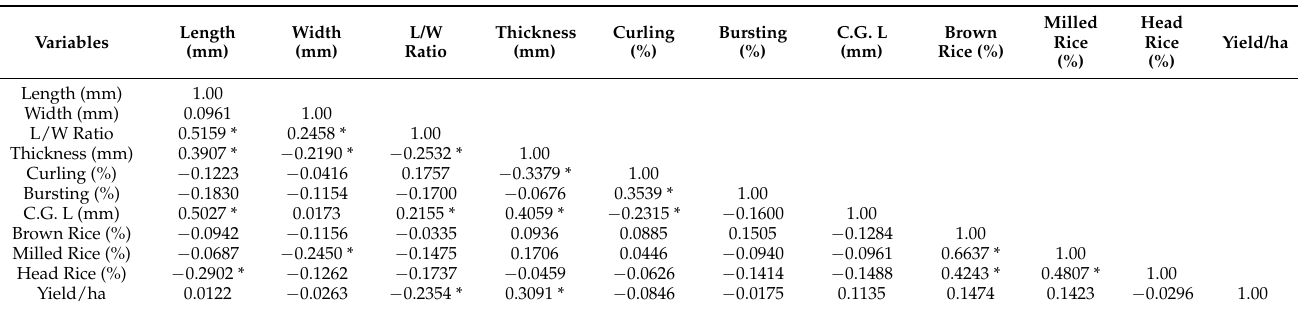
Table 5. Association of various morphological, quality and yield traits of hybrid rice in adaptability trials 2020.